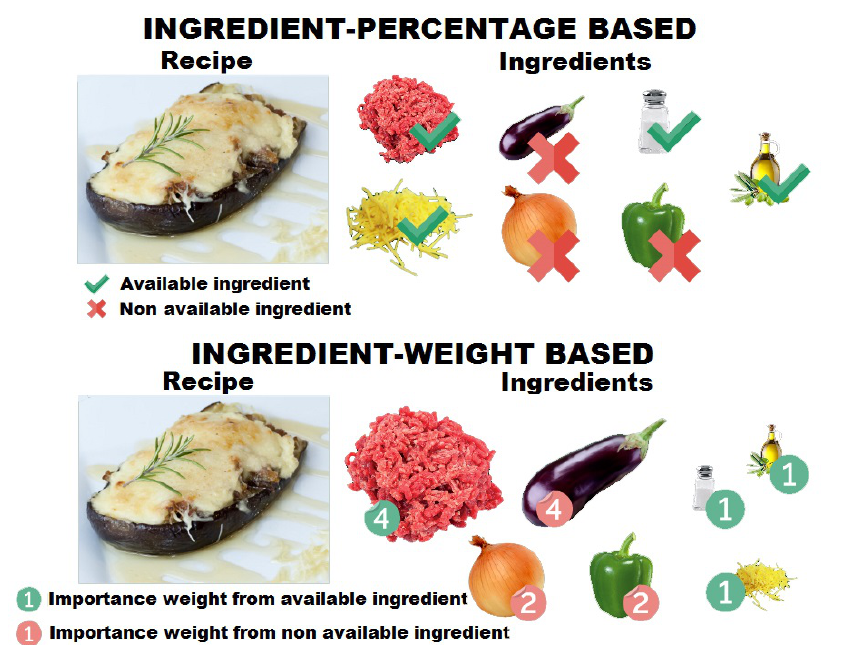
Figure 6. Example of a recipe recommendation using our proposed